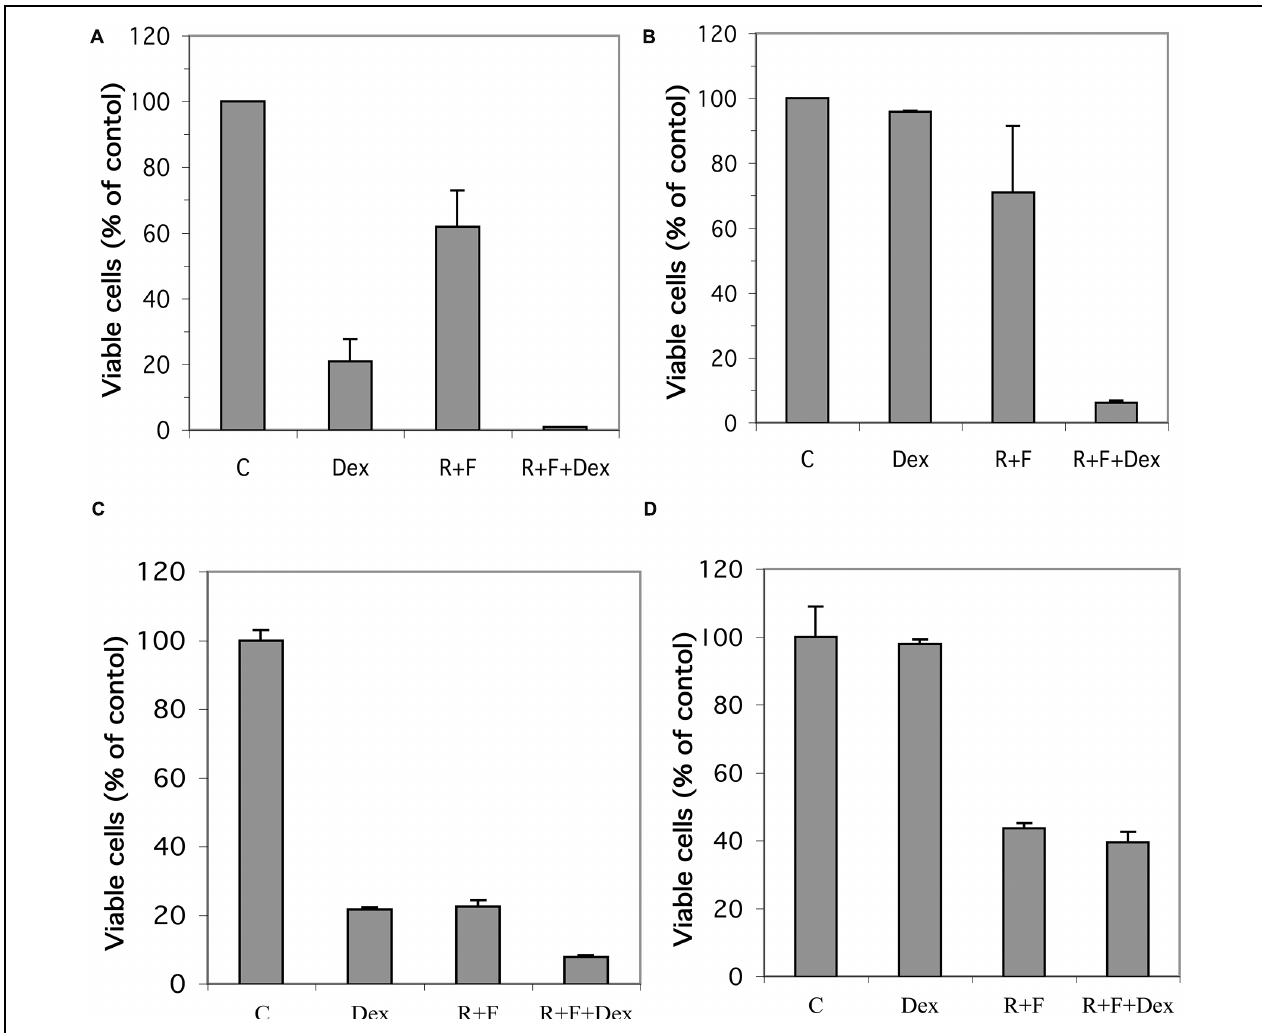
FIGURE 1 | Effect of dexamethasone, rolipram, and forskolin on viability of glucocorticoid-sensitive and glucocorticoid-resistant CEM and MM.1 cells. (A) CEM-S2 cells, (B) CEM-R8 cells, (C) MM.1S cells, and (D) MM.1R cells were treated with 1 µ M dexamethasone (Dex), 10 µ M rolipram plus 10 µ M forskolin (R + F), or 1 µ M dexamethasone plus 10 µ M rolipram plus 10 µ M forskolin (R + F + Dex) for 72 h. Cell viability was then determined by the MTS method. Data represent the mean ± SD of at least two independent experiments assayed in triplicate.